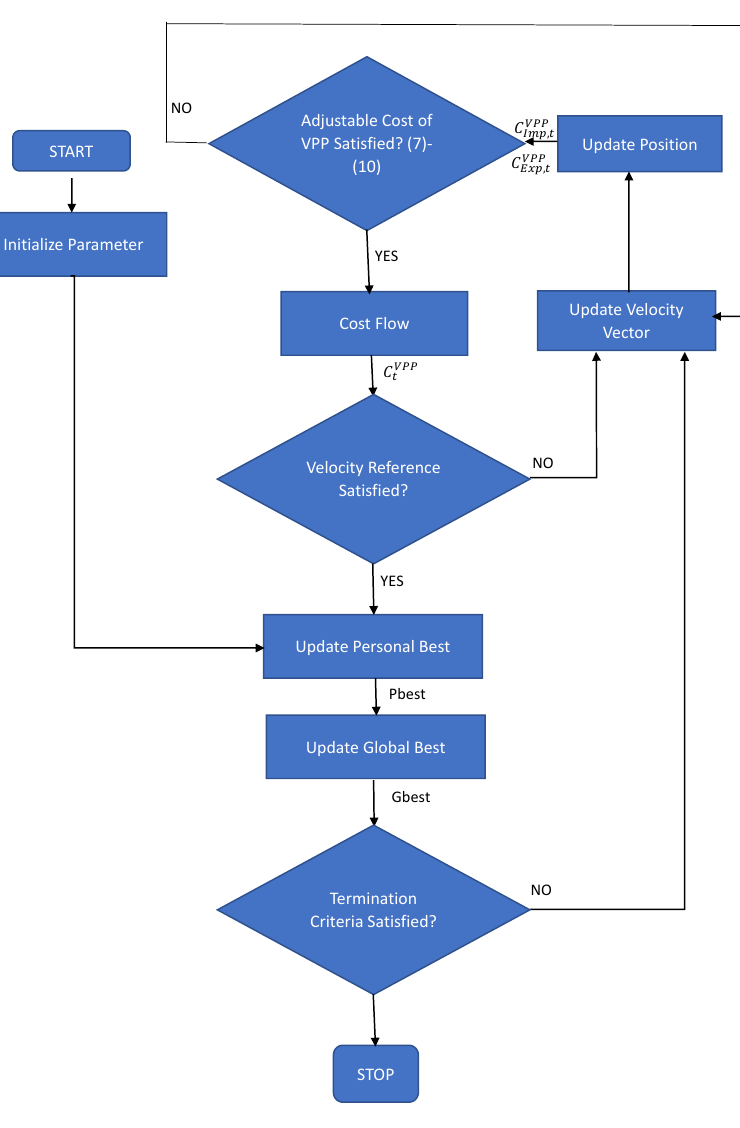
Figure 4. PSO algorithm.